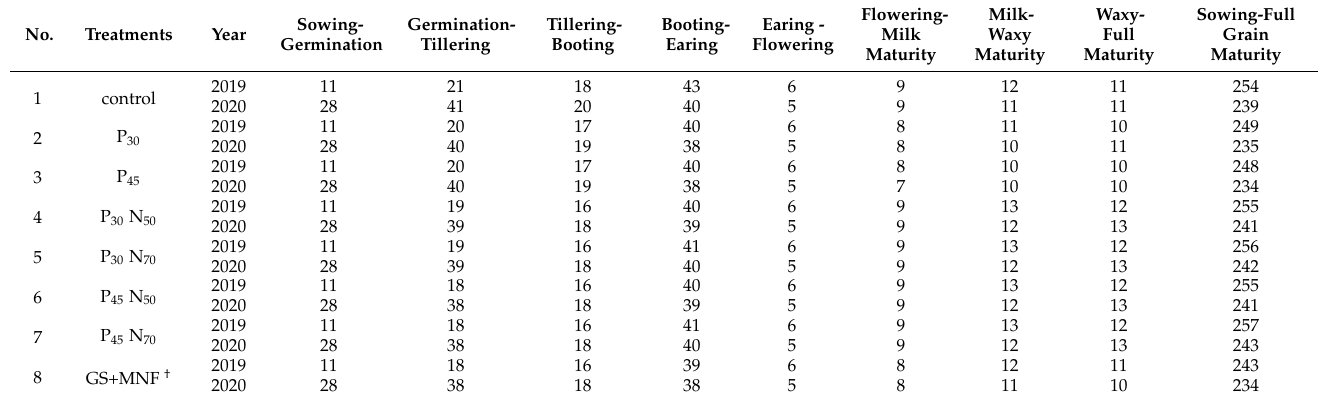
Table 3. Phenological phases of development of winter wheat with direct sowing depending on fertilization in South Kazakhstan (days after